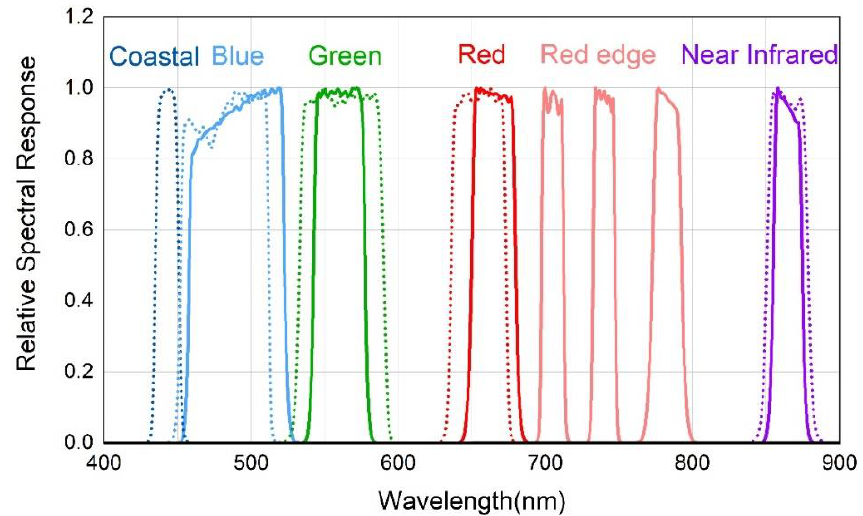
Figure 3. Relative spectral response from 400 nm to 900 nm. Solid lines represent the relative spectral response of Landsat-8 bands. Dotted lines represent the relative spectral response of Sentinel-2 bands.